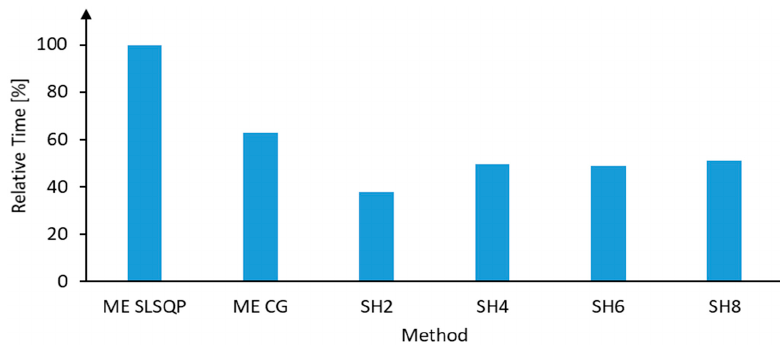
Figure 11. Overview of average computational time of the reconstruction methods.